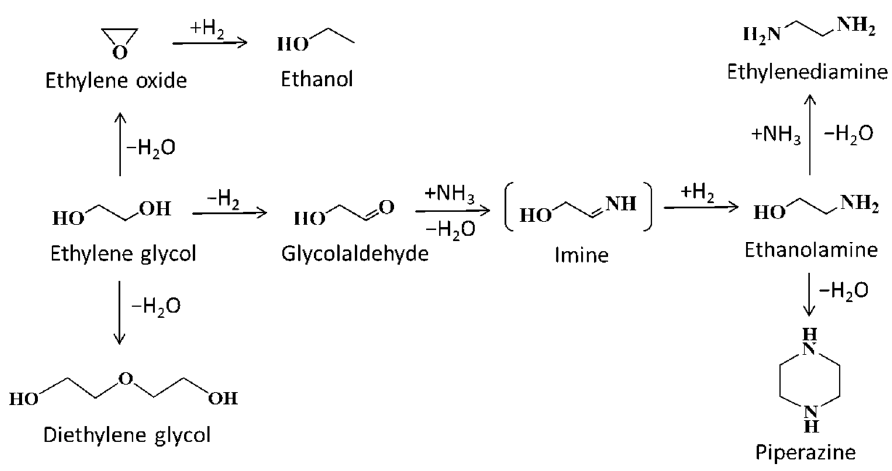
Scheme 2. Proposed reaction pathways for ethylene glycol conversion on Co/ γ -Al 2 O 3 in the presence of NH 3 and H 2 based on the products